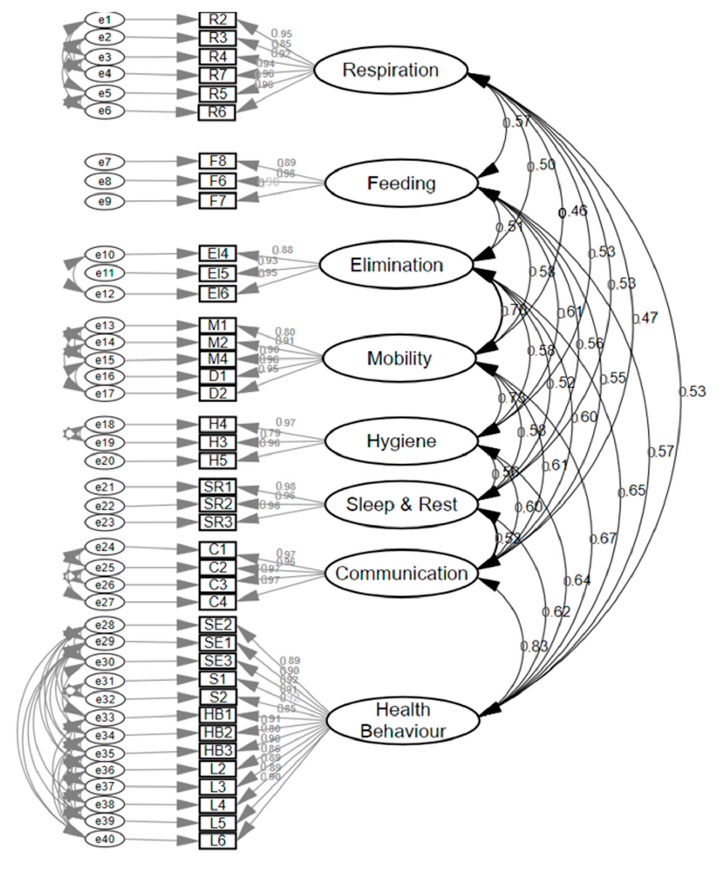
Figure 2. Confirmatory factor analysis 40-item scale (large form version).